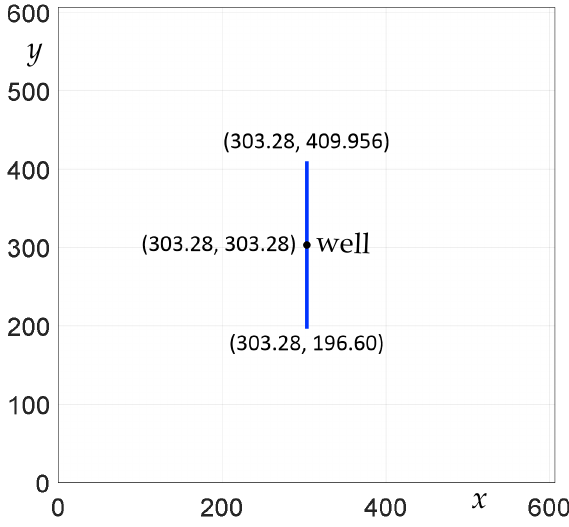
Figure 10. Scheme for the comparison with the CMG (Computer Modelling Group Ltd.) simulator (simulations VE1A,